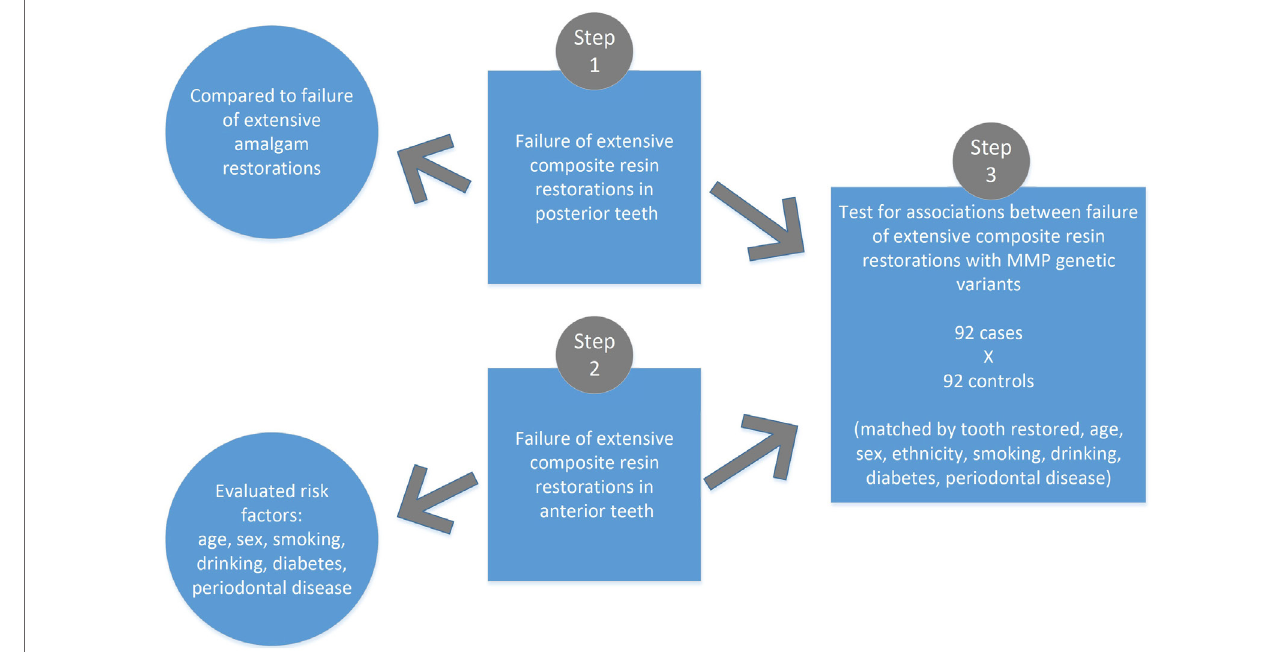
FigUre 1 | Summary of the study